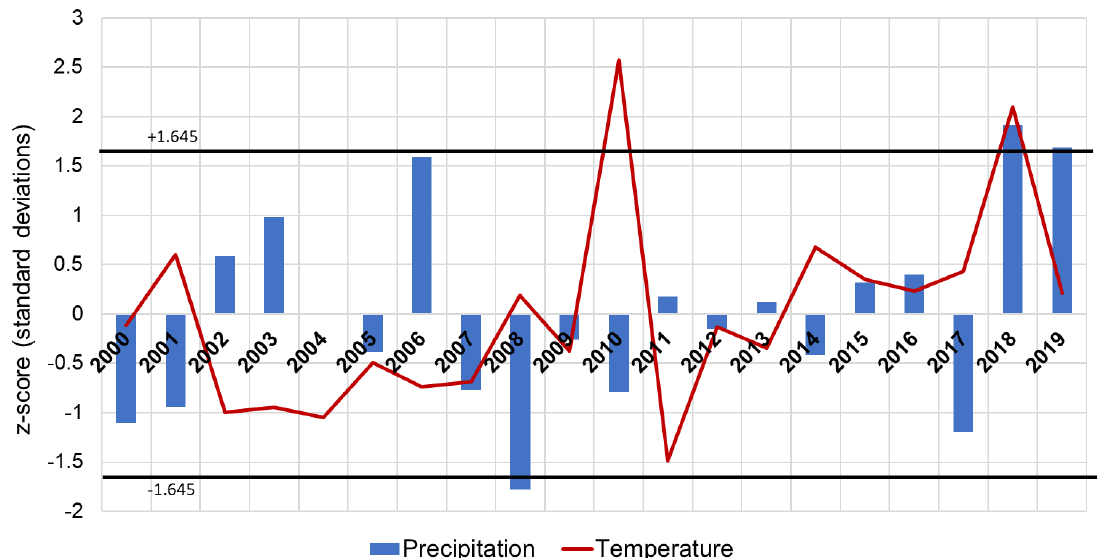
Figure 7. Standardized anomalies of annually summed precipitation and mean annual land surface temperature (z-scores) over the KR-I area, 2000–2019. The precipitation data are based on Climate Hazards Group InfraRed Precipitation with Station dataset, and the land surface temperature data are based on the ERA5-Land dataset. The horizontal lines ( ± 1.645) indicate the critical values that indicate the significance of the z-score at the 90% level.